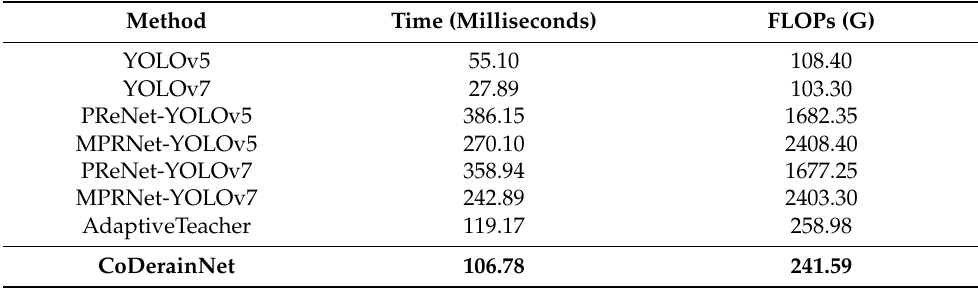
Table 6. Comparison of different methods in terms of inference time and calculation